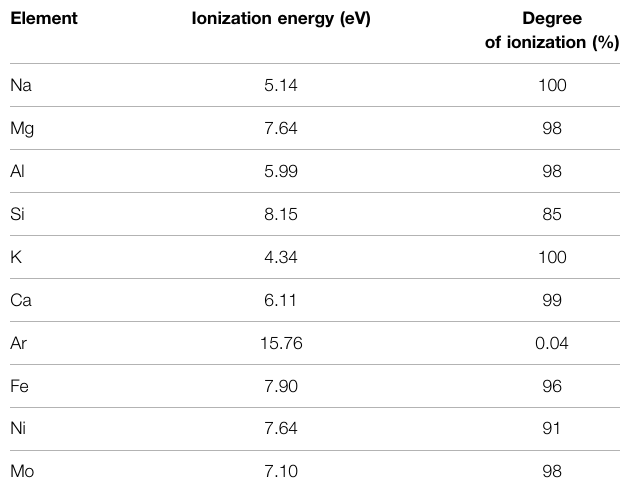
TABLE 3 | First ionization energies and degrees of ionization for each element of